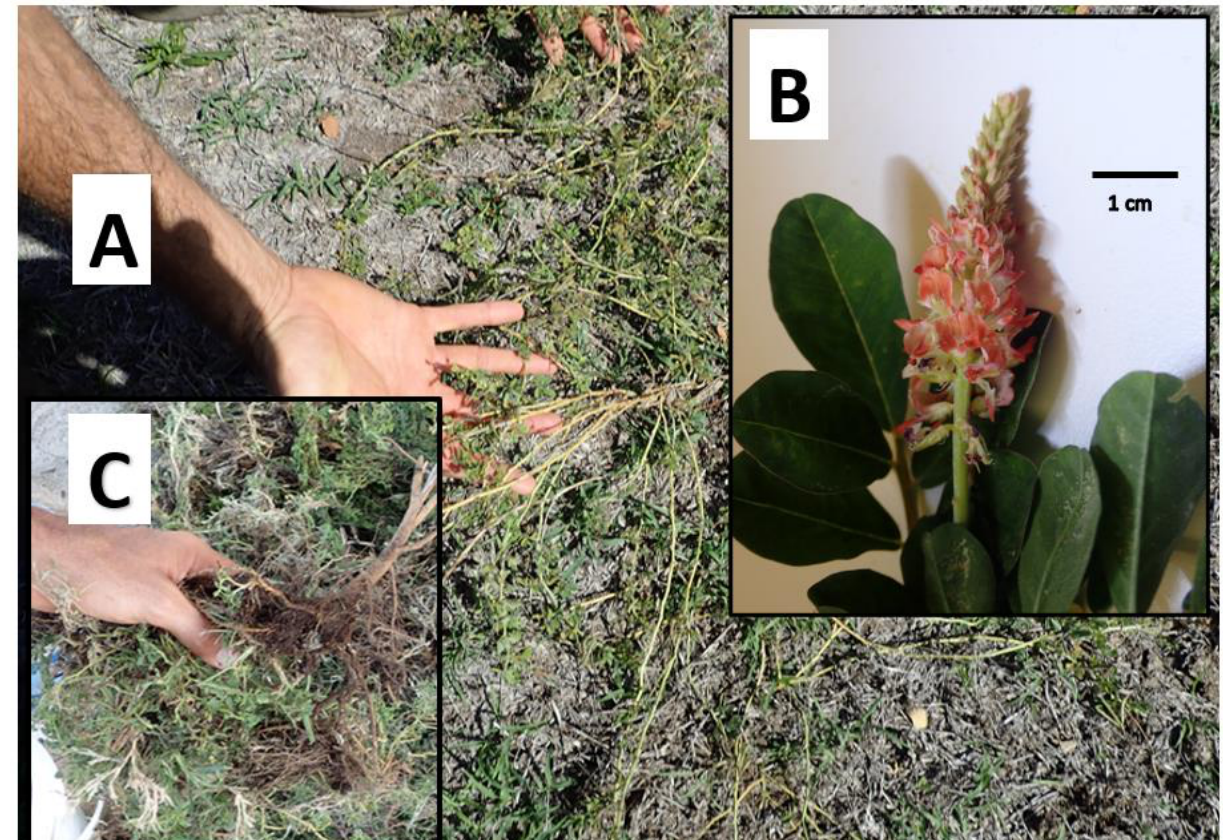
Figure 1. Creeping indigo, Indigofera spicata , filling pastures on Oahu island: ( A ) creeping indigo mature plant with stems creeping along very close to the ground, making it hard to notice among other foliage, ( B ) bunch showing pink flowers and the oblong, pinnate leaves typical of Fabaceae, ( C ) uprooted plant showing tough deep central roots that are difficult to kill with conventional herbicides and must be dug out. Creeping indigo also spreads by its long, hard-to-pull roots and seeds, making it difficult to fully kill it in one round.